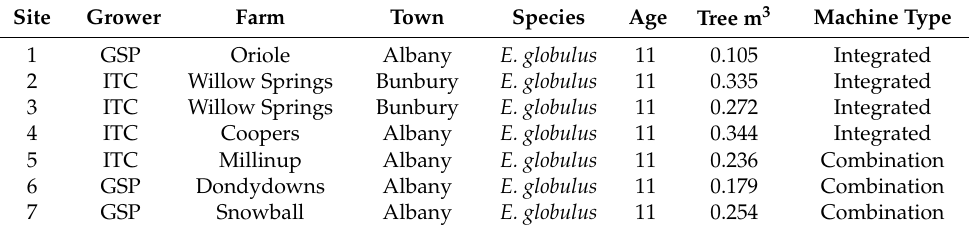
Table 1. Trial sites: compartment information.